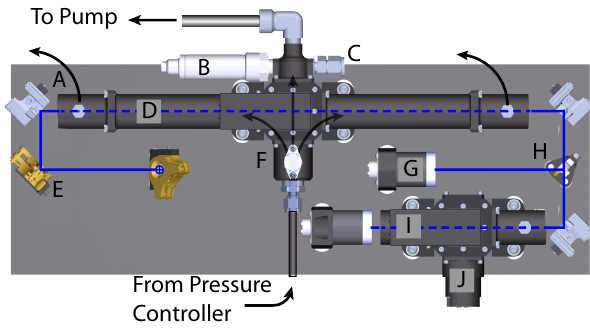
Figure 3. This diagram shows a top view of the optical bench with the harmonic generation housing and platform removed. The laser propagation is indicated by the solid (open to air) and dashed (in- side the cells) blue lines. The sample flow is indicated by the black arrows. The components are (A) piezo actuated mirror (3); (B) pres- sure sensor; (C) thermistor; (D) sample detection cell; (E) fixed mirror; (F) sample heater; (G) reference cell (2); (H) beam splitter; (I) reference cell; (J) formaldehyde source.